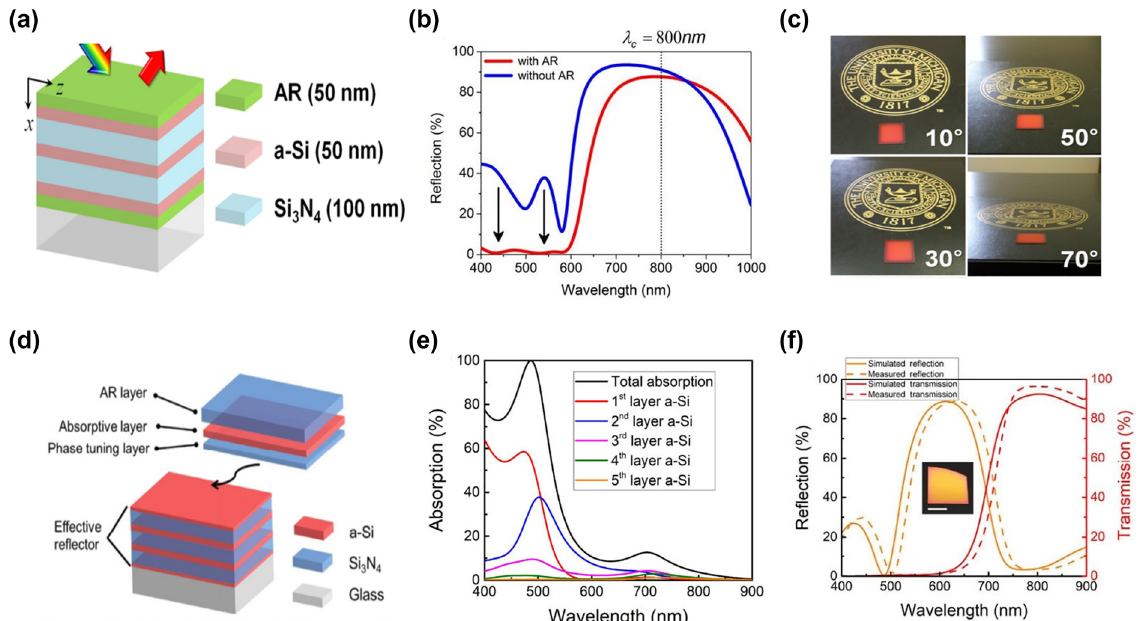
Figure 8: 1D photonic crystal resonance for structural color generation. (a) Schematic diagram of the proposed 1D photonic crystal for generating red color, which consists of alternating layers of α -Si and Si curve) and without (blue solid curve) the AR coating. (c) Optical images of a fabricated sample under four different viewing angles. Modified with permission [113]. Copyright 2015, Wiley-VCH. (d) Schematic diagram of the 1D photonic crystal-based device for reflective CMY color generation. The device is composed of PC stacks (alternating a-Si and Si and separated absorption in each α -Si layer over the visible band. (f) Calculated (yellow solid curve) and measured (yellow dashed curve) reflection spectra of the proposed device. The red curves are transmission spectra of the bottom PC stacks. Inset: optical image of a fabricated sample. Scale bar: 1 cm. Reproduced with permission [114]. Copyright 2019, Tsinghua University